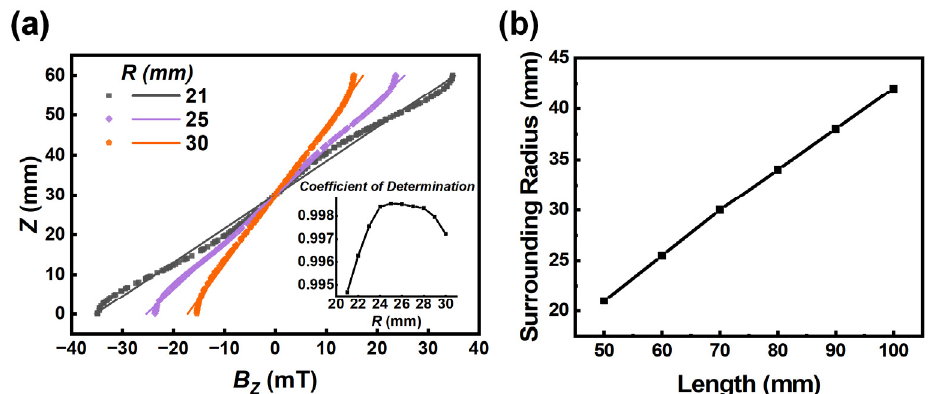
Figure 5. ( a ) Magnetic flux density profile along the centerline for different surrounding radii R . Points are the simulation results, and the corresponding lines were obtained by linear fitting. The coefficients of determination for the linear fitting are listed in the insert. ( b ) Relationship between the optimized surrounding radius and magnet length.